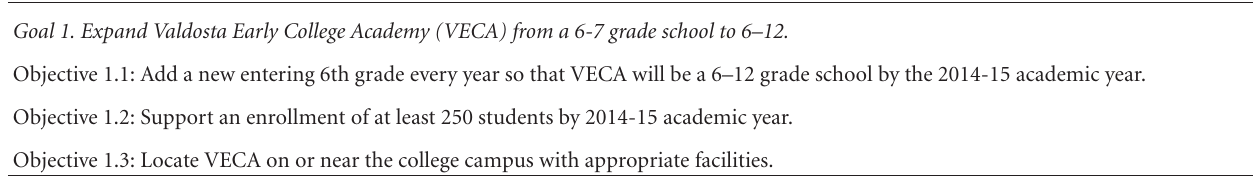
Table 1: Quantitative and qualitative evaluation of goals in relation to program